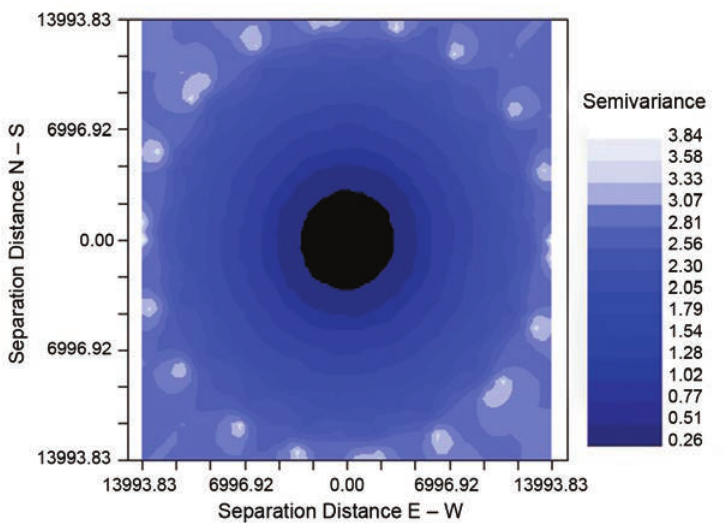
Fig. 5. The model of variogram